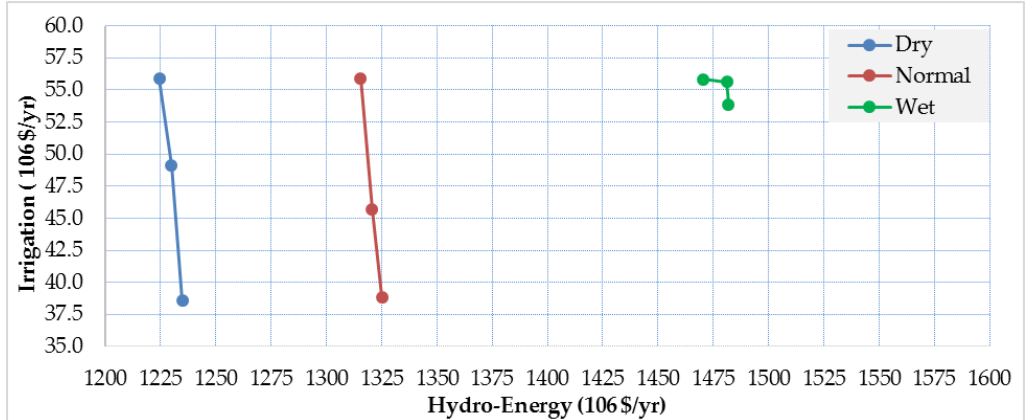
Figure 8. Optimal Pareto Front of two objective functions for Ethiopia’s part of the Eastern Nile system for three hydrologic conditions (dry, normal and wet) for the non-cooperative management scenario .